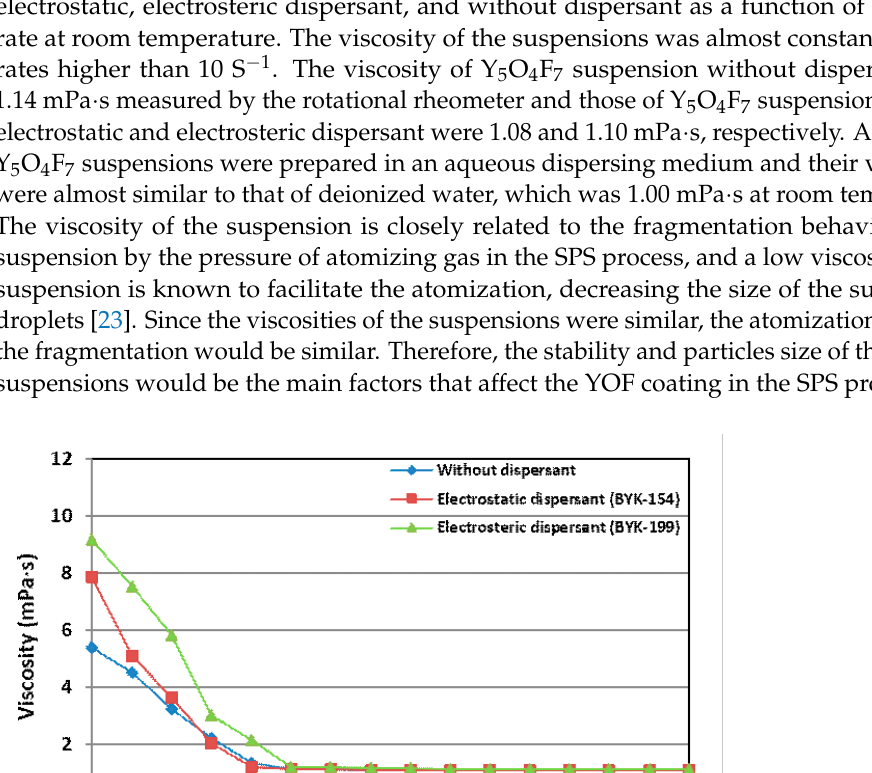
Figure 6. Relative sedimentation height of Y 5 O 4 F 7 suspensions with two types of dispersants and without dispersant as a function of time.